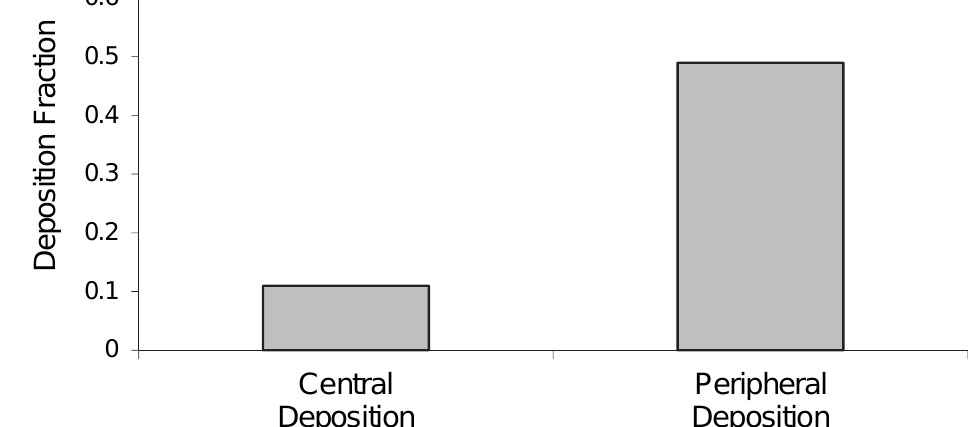
Fig. 8 Central versus peripheral lung deposition fractions for HFA based metered dose inhalers as predicted by the in silico model.